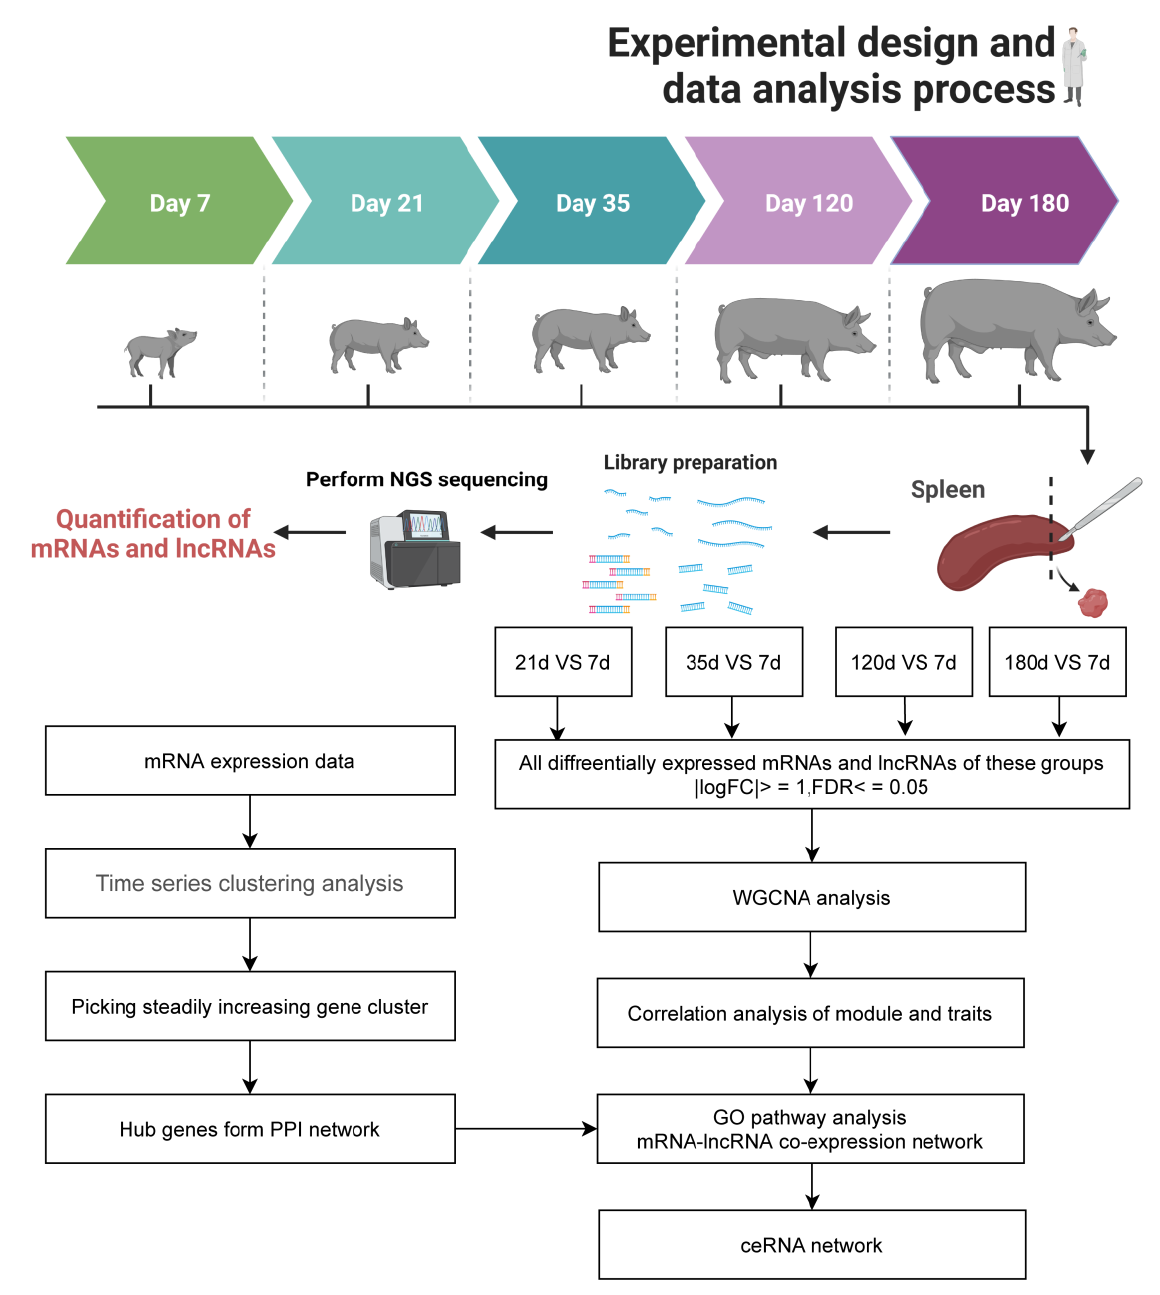
Figure 1. Graphical summary of the experimental design and bioinformatics analysis process. Spleen samples from five different time points (7 d, 21 d, 35 d, 120 d and 180 d) were collected and subjected to RNA-seq (n = 3 samples per time point), followed by downstream analyses.